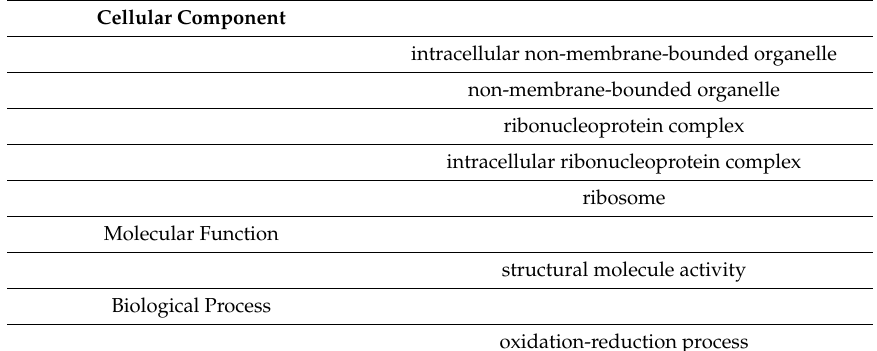
Table 2. Common GO terms under CP48 vs. CP65, CP48 vs. CP75, SP48 vs. SP65, and CP48 vs.